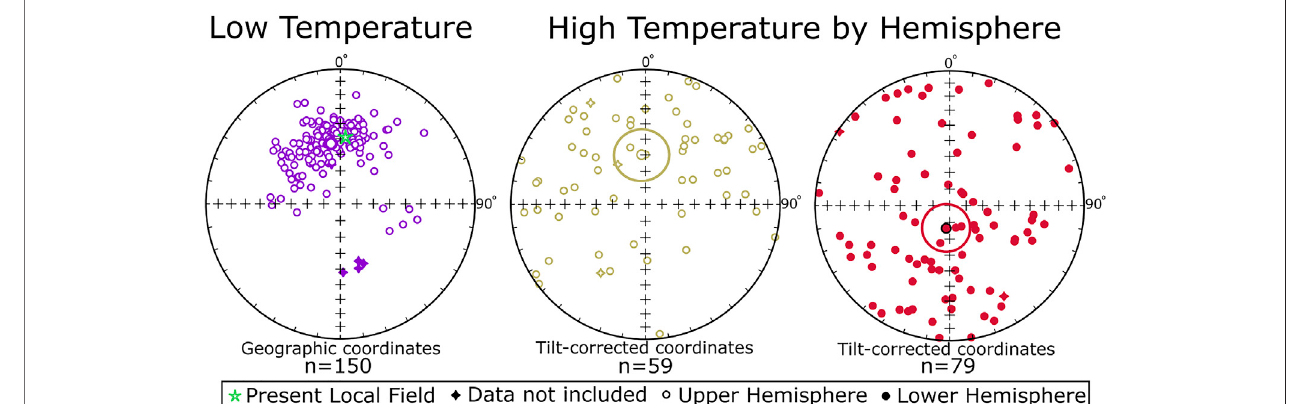
FIGURE 5 | Paleomagnetic Directions for MR1 samples. Equal area plots for low-temperature components and high-temperature components, separated into upper and lower hemispheres. The present local fi eld when the core was collected in July 2010 (D (cid:1) 2.916 ° , I (cid:1) − 49.602 ° ) is indicated with a green star on the low temperaturepanel.Thelow-temperature fi tsclusterclosetothepresentlocal fi eld(FishermeanD (cid:1) 350.3 ° ,I (cid:1) − 45.6 ° , α 95 (cid:1) 3.4 ° , n (cid:1) 150.Geographiccoordinates).The high-temperature fi tshavemorespread (UpperHemisphereFishermeanD (cid:1) 355.5 ° ,I (cid:1) − 59.7 ° , α 95 (cid:1) 16.2, n (cid:1) 59.LowerHemisphereFishermeanD (cid:1) 188.9 ° ,I (cid:1) 76.3 ° , α 95 (cid:1) 14.4 ° , n (cid:1) 79. Tilt-corrected coordinates). Values for n represent fi ts not hidden, so they do not include the fi ve samples with anomalous low-temperature